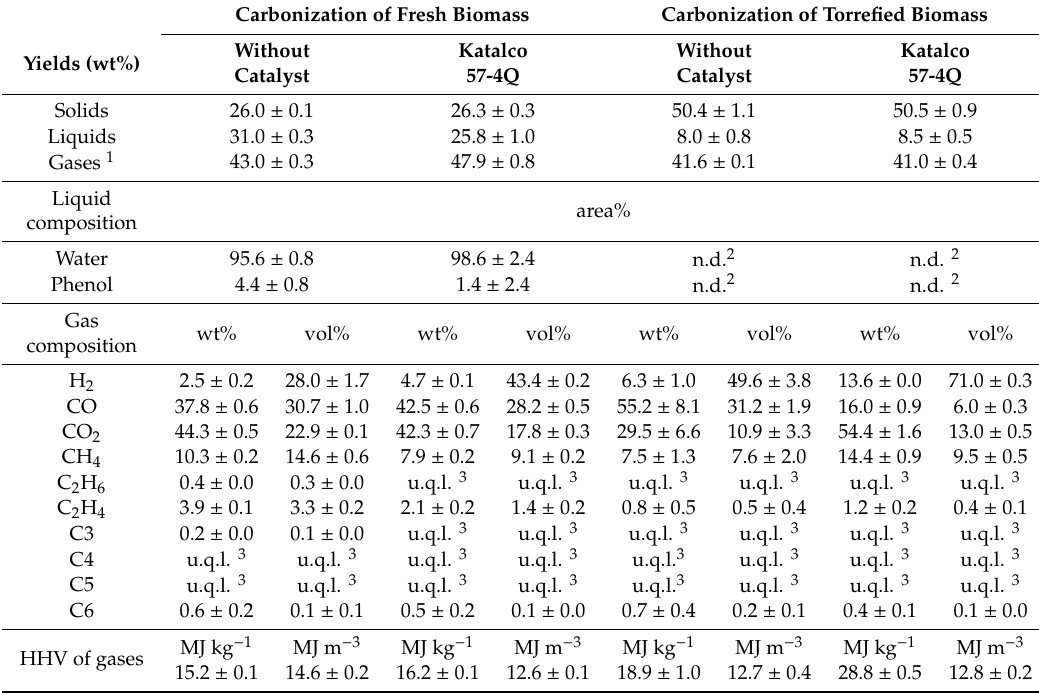
Table 2. Carbonization yields, liquid composition, and gas